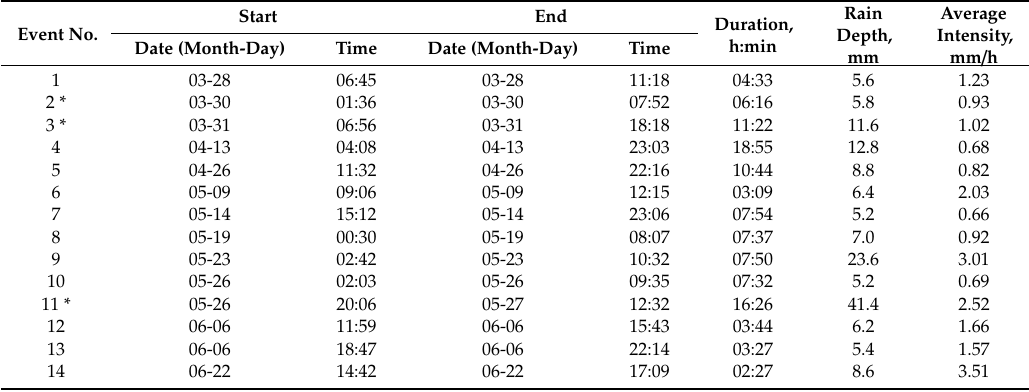
Table 1. Summary of the rain events during the monitoring campaign with a rain depth of 5 mm or